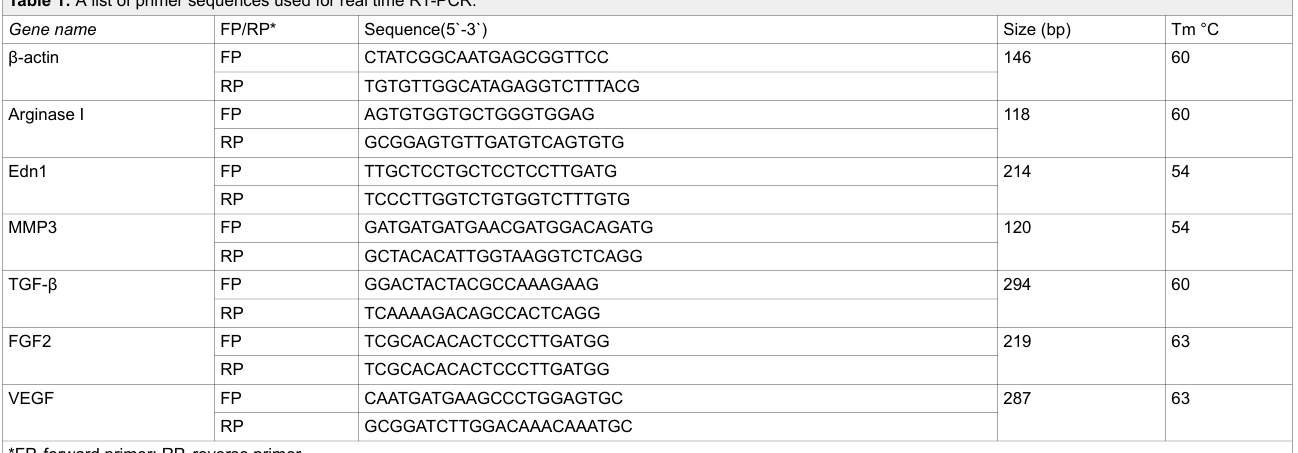
Table 1: A list of primer sequences used for real time RT-PCR.